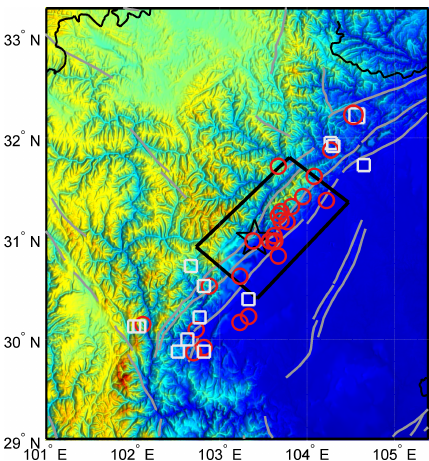
Figure 5. Epicentral distribution of PEQs (red circles) and NEQs (white squares) ( M L ≥ 3 . 0) that occurred along the Longmenshan fault from January 2005 to April 2008. The star shows the epicenter of the Wenchuan